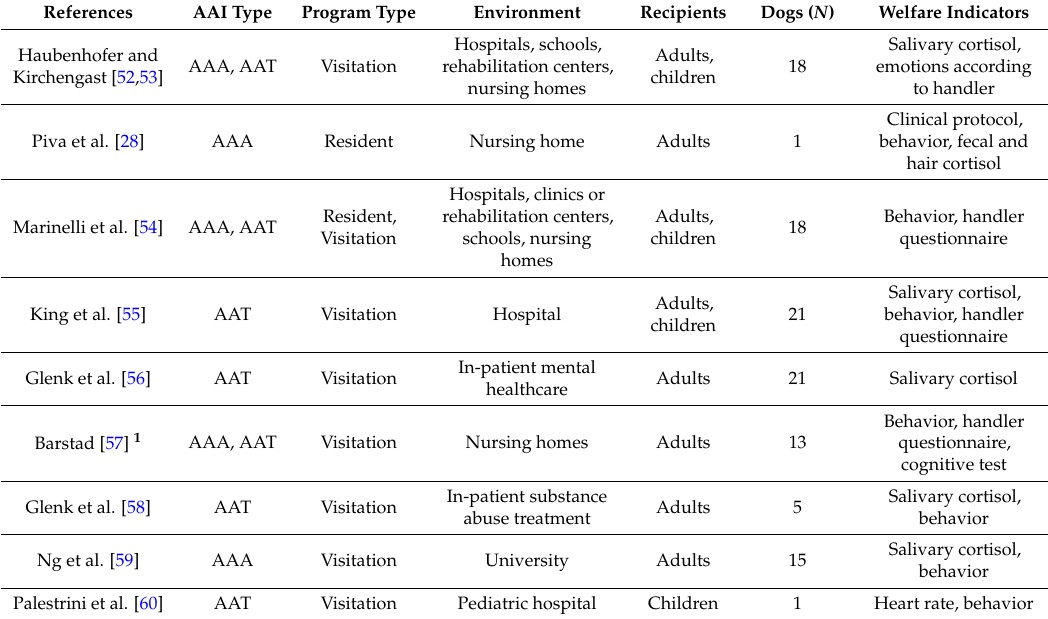
Table 1. Overview on program definitions, therapeutic environment, recipients, sample of dogs and welfare indicators. AAA: animal-assisted activity; AAI: animal-assisted interventions; AAT: animal-assisted